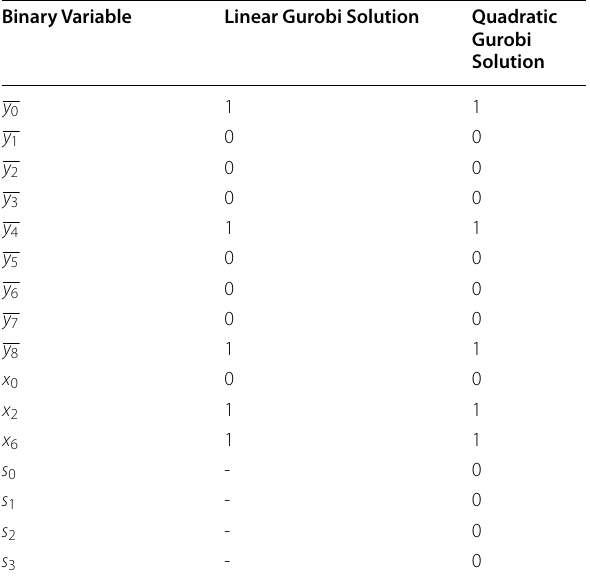
Table 2 Gurobi classical quadratic and linear program